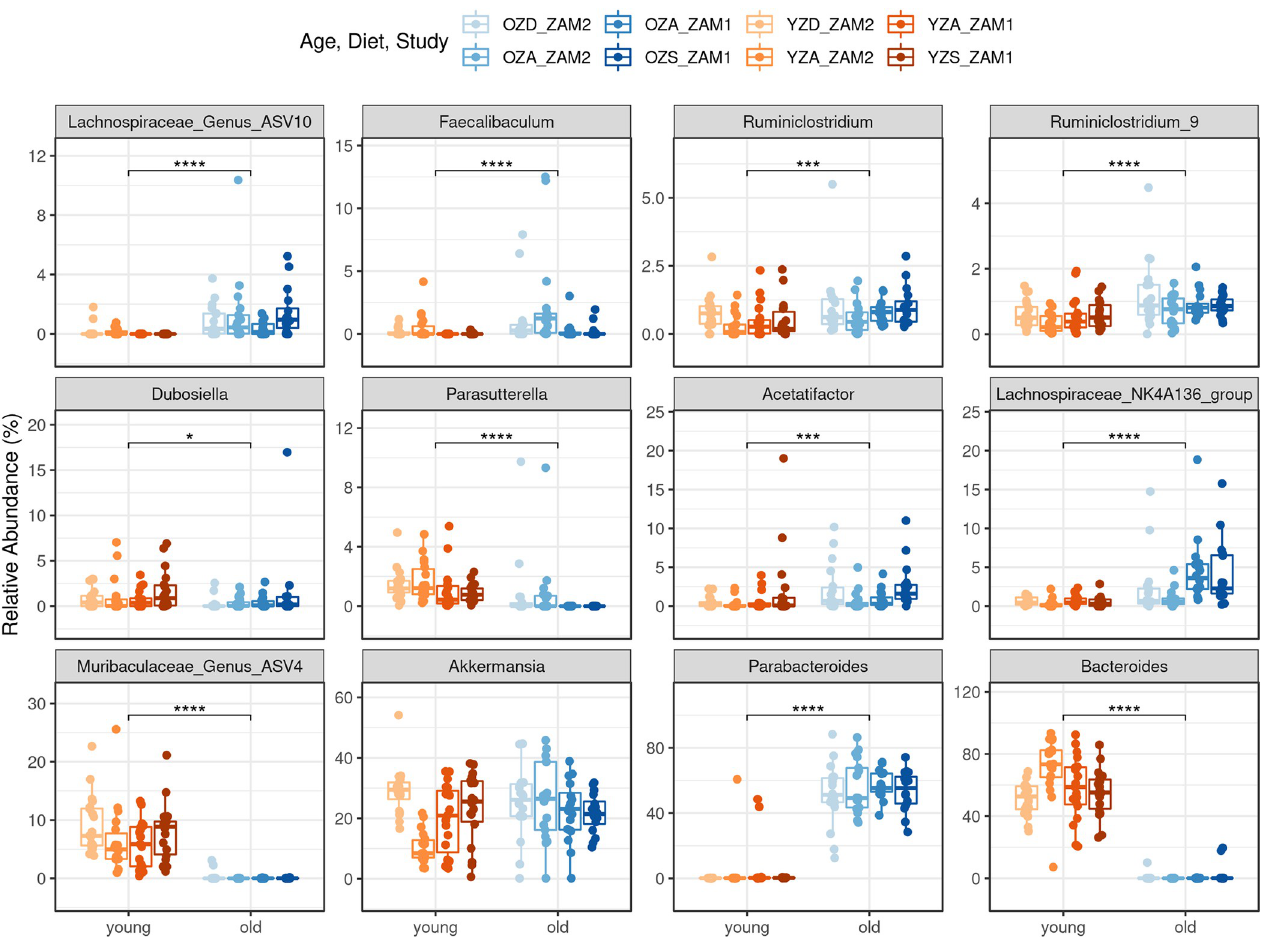
Fig 2. Eleven of the top 12 most abundant genera are significantly different between young and old mice. Boxplots display relative abundance of each of the top twelve most abundant genera in the study, with the first, median, and third quartiles shown by the hinges, and the whiskers extend to no more than 1.5 x inter-quartile range, with outliers plotted individually. Additionally, each data point is shown as a jittered point value. Boxplots and points are colored based on age by diet by study groups, as shown. Significance values are shown based on a Wilcoxon Rank Sum test between young and old mice, with � , �� , ��� , and ���� corresponding to p-values of 0.05, 0.01, 0.001, and 0.0001, respectively. ZAM1—supplementation study, ZAM2—deficiency study, OZD—old zinc deficient, OZA—old zinc adequate, OZS—old zinc supplemented, YZD—young zinc deficient, YZA—young zinc adequate, YZS—young zinc supplemented. n = 75 young mice fecal samples, n = 67 old mice fecal samples, including week 0 and week 6 fecal samples.